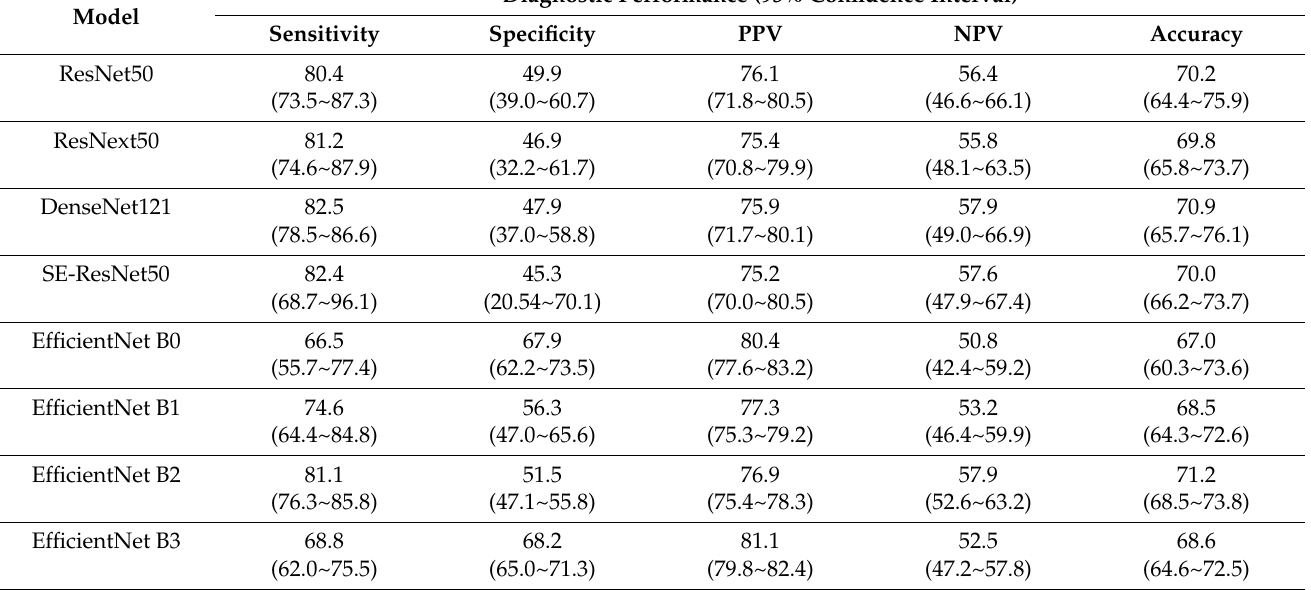
Table 1. Diagnostic performance of eight state-of-art deep learning models for identifying Pseu- domonas keratitis in bacterial